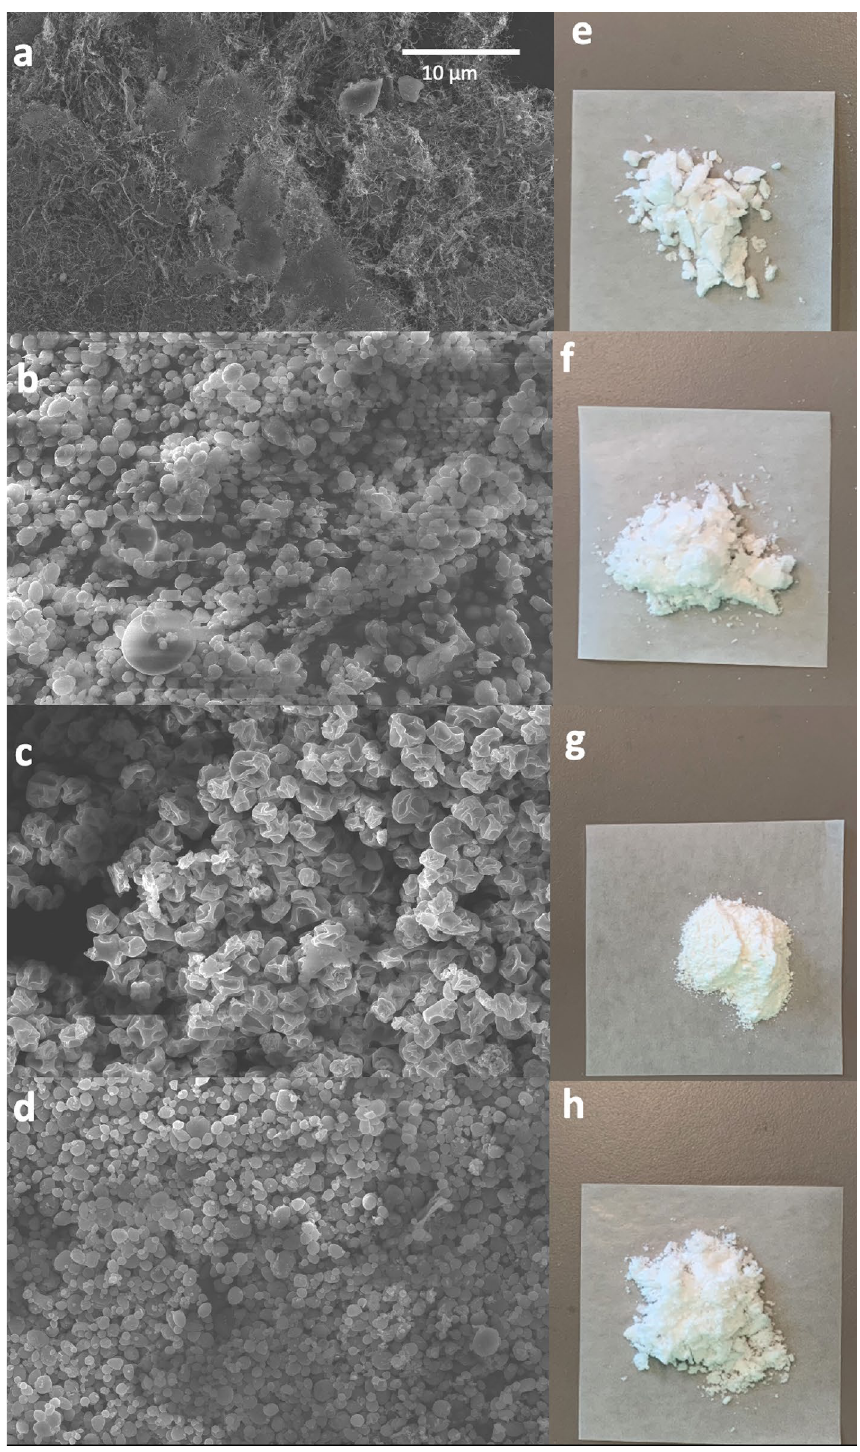
Figure 2. Morphology of different dehydrated insulin NPs: ( a ) SEM image of freeze-dried insulin NPs without mannitol; ( b ) SEM image of freeze-dried insulin NPs with mannitol; ( c ) SEM image of spray-dried insulin NPs without mannitol; ( d ) SEM image of spray-dried insulin NPs with mannitol; ( e ) Image of freeze-dried insulin NPs powder without mannitol; ( f ) image of freeze-dried insulin NPs with mannitol; ( g ) Image of spray-dried insulin NPs powder without mannitol; ( h ) Image of spray-dried insulin NPs powder with